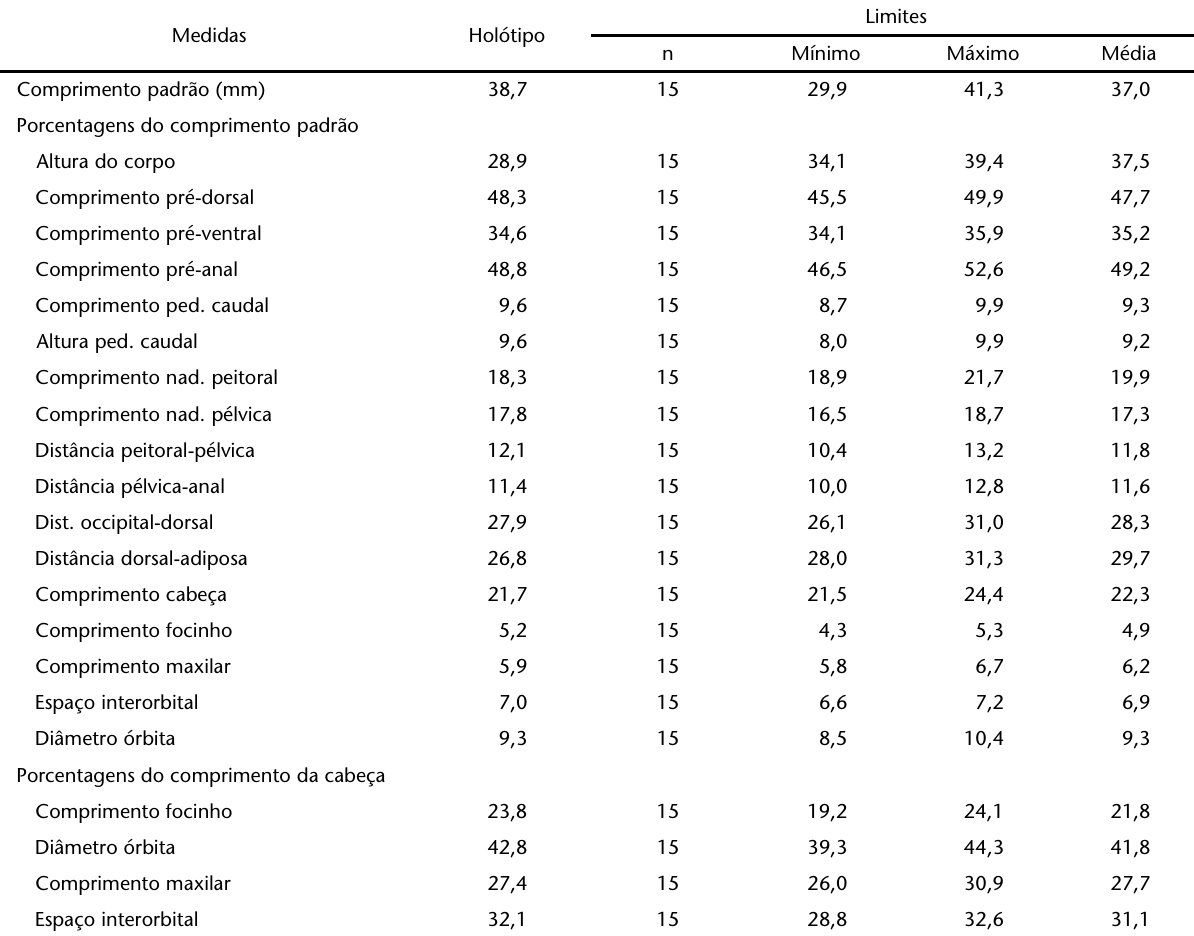
Tabela I. Medidas de P. capitulatus sp. nov. , holótipo MUSM 20424. (n) Número de exemplares, incluindo o